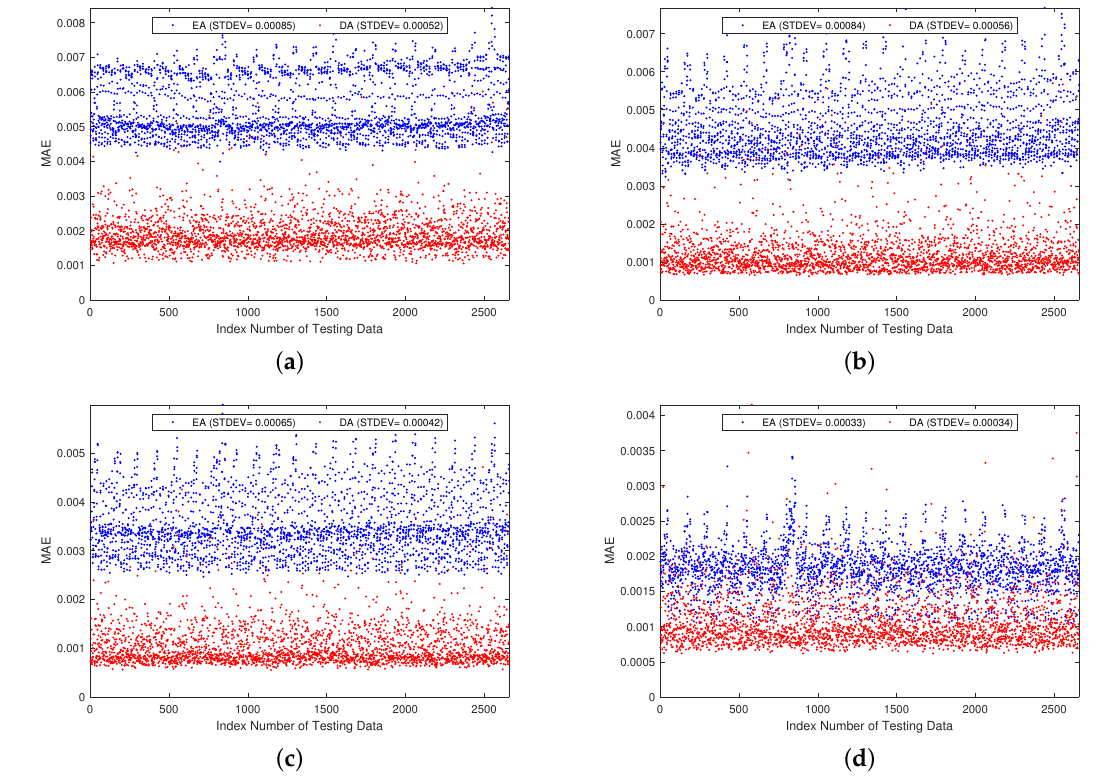
Figure 4. MAE of each individual testing data. ( a ) (cid:101) = 0.1; ( b ) (cid:101) = 0.5; ( c ) (cid:101) = 1.0; ( d ) (cid:101) = 1.5.